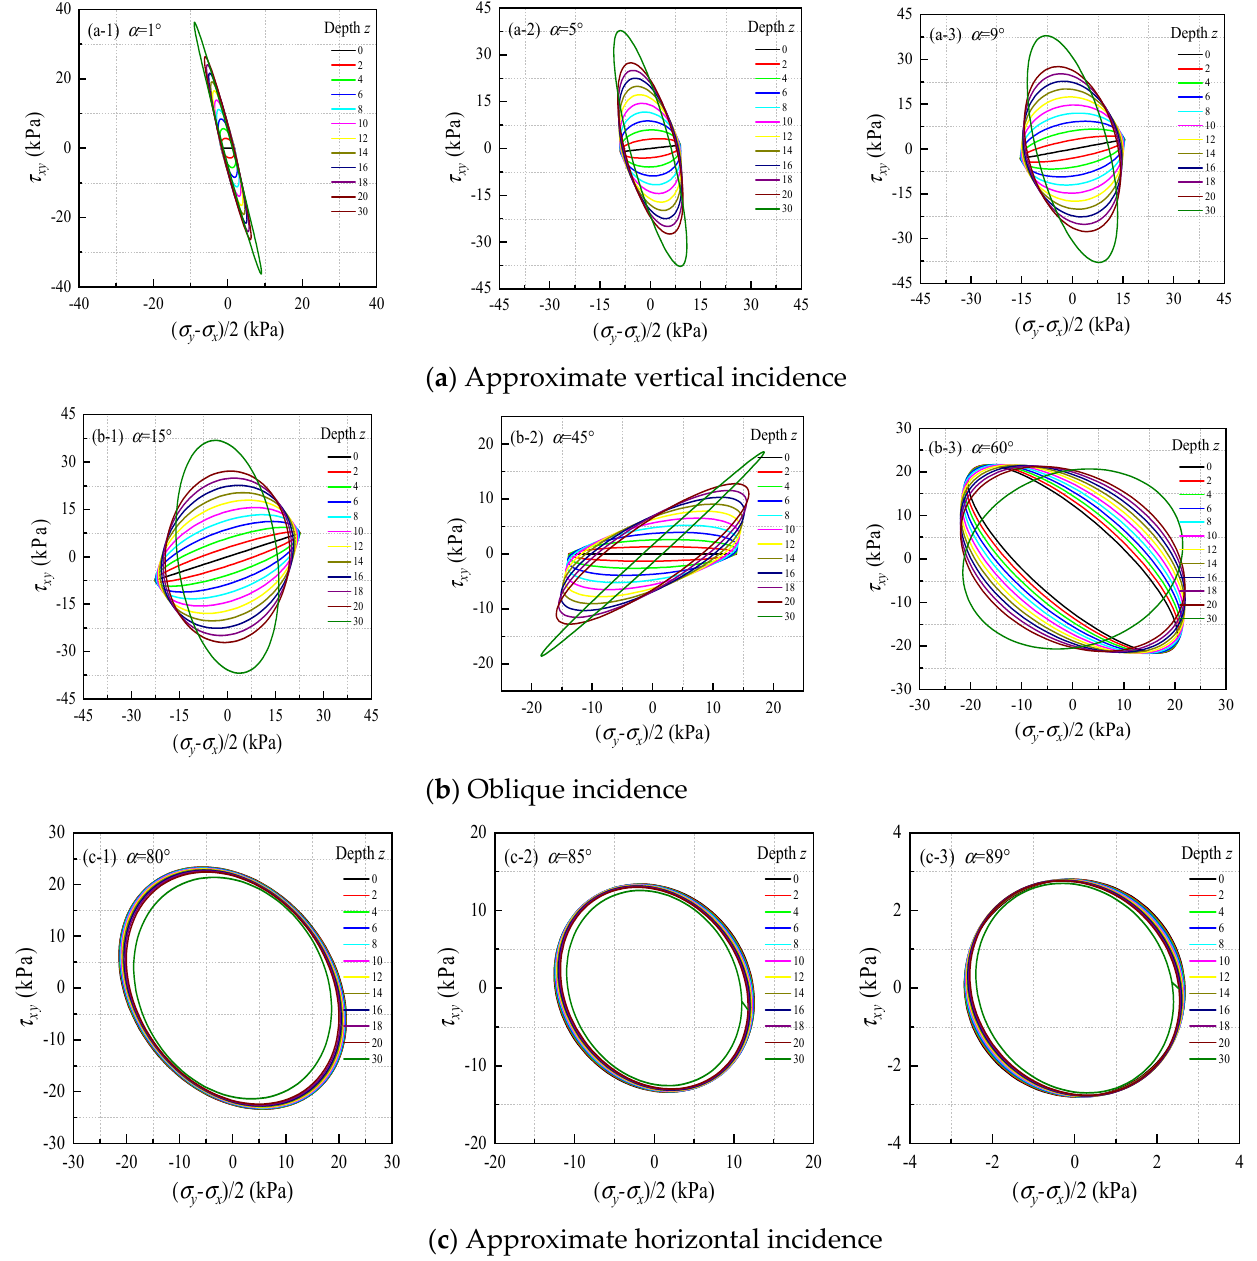
( c ) Approximate horizontal incidence Figure 13. Variation of elliptical stress path with the soil depth for different incidence conditions.